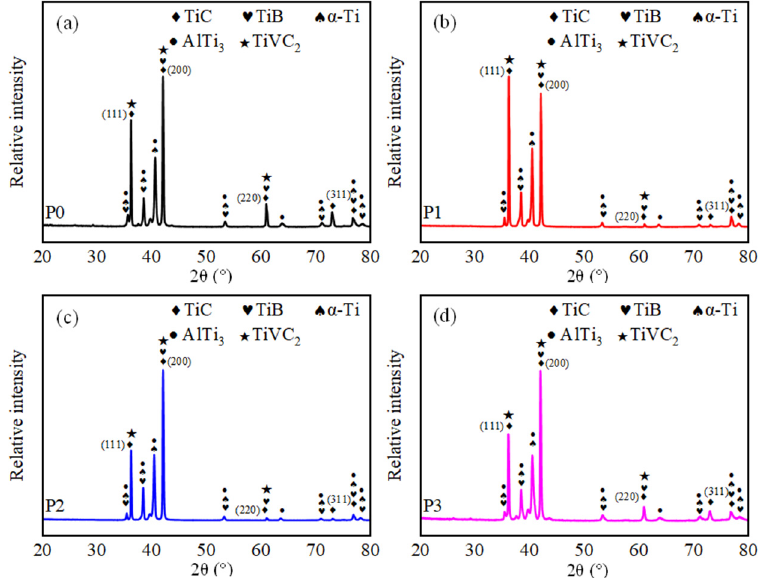
Figure 5. XRD pattern of ceramic coatings fabricated with different ultrasonic power: ( a ) P0-Coating, ( b ) P1-Coating, ( c ) P2-Coating, ( d )